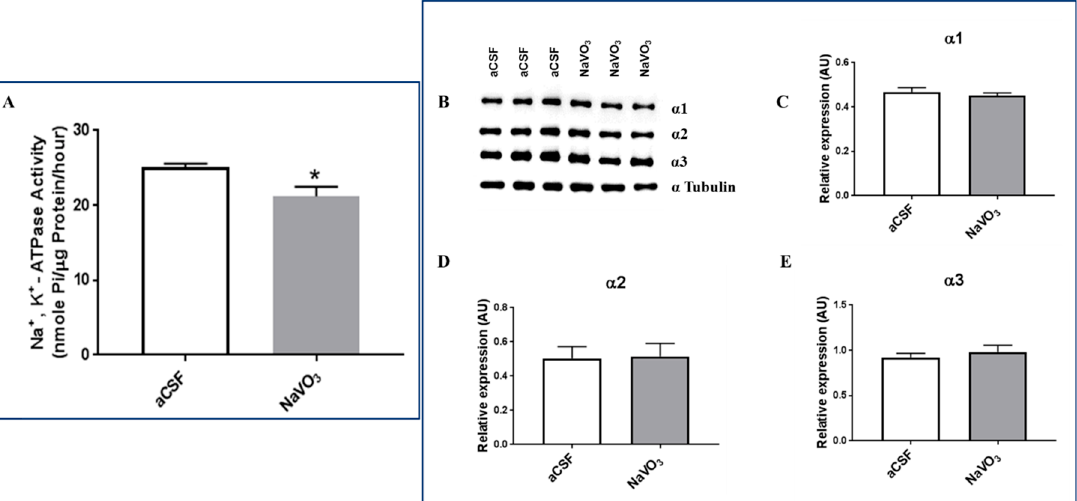
Figure 5. Effect of NaVO 3 administration on brain Na + , K + ‐ ATPase activity and Na + , K + ATPase α isoform expression. Mice were treated with NaVO 3 (3 μ L from a 10 mM stock solution in aCSF) and their behavior was examined as described in the legend to Figures 3 and 4. Following the behavioral tests (Figure 4) the mice were euthanized. The brains were exposed and the frontal cortex was dis ‐ sected. A microsomal fraction was prepared and Na + , K + ‐ ATPase activity was determined as de ‐ scribed in Materials and Methods. Na + , K + ‐ ATPase activity ( A ) is expressed as the mean ± SEM ( n = 6). Na + , K + ‐ ATPase activity in the control mice (25.72 nmol Pi/ μ g protein/h) represented 35% of the total ATPase activity (71.94 nmol Pi/ μ g protein/h) in this membrane preparation. Na + , K + ‐ ATPase α subunit isoform expression was determined by western blot analysis as described in Materials and Methods. ( A ): Representative western blots. ( B ): Quantitative α isoform expression (C–E) values were normalized to the levels of α Tubulin ( n = 4). * significantly lower than in mice receiving aCSF, p < 0.005.